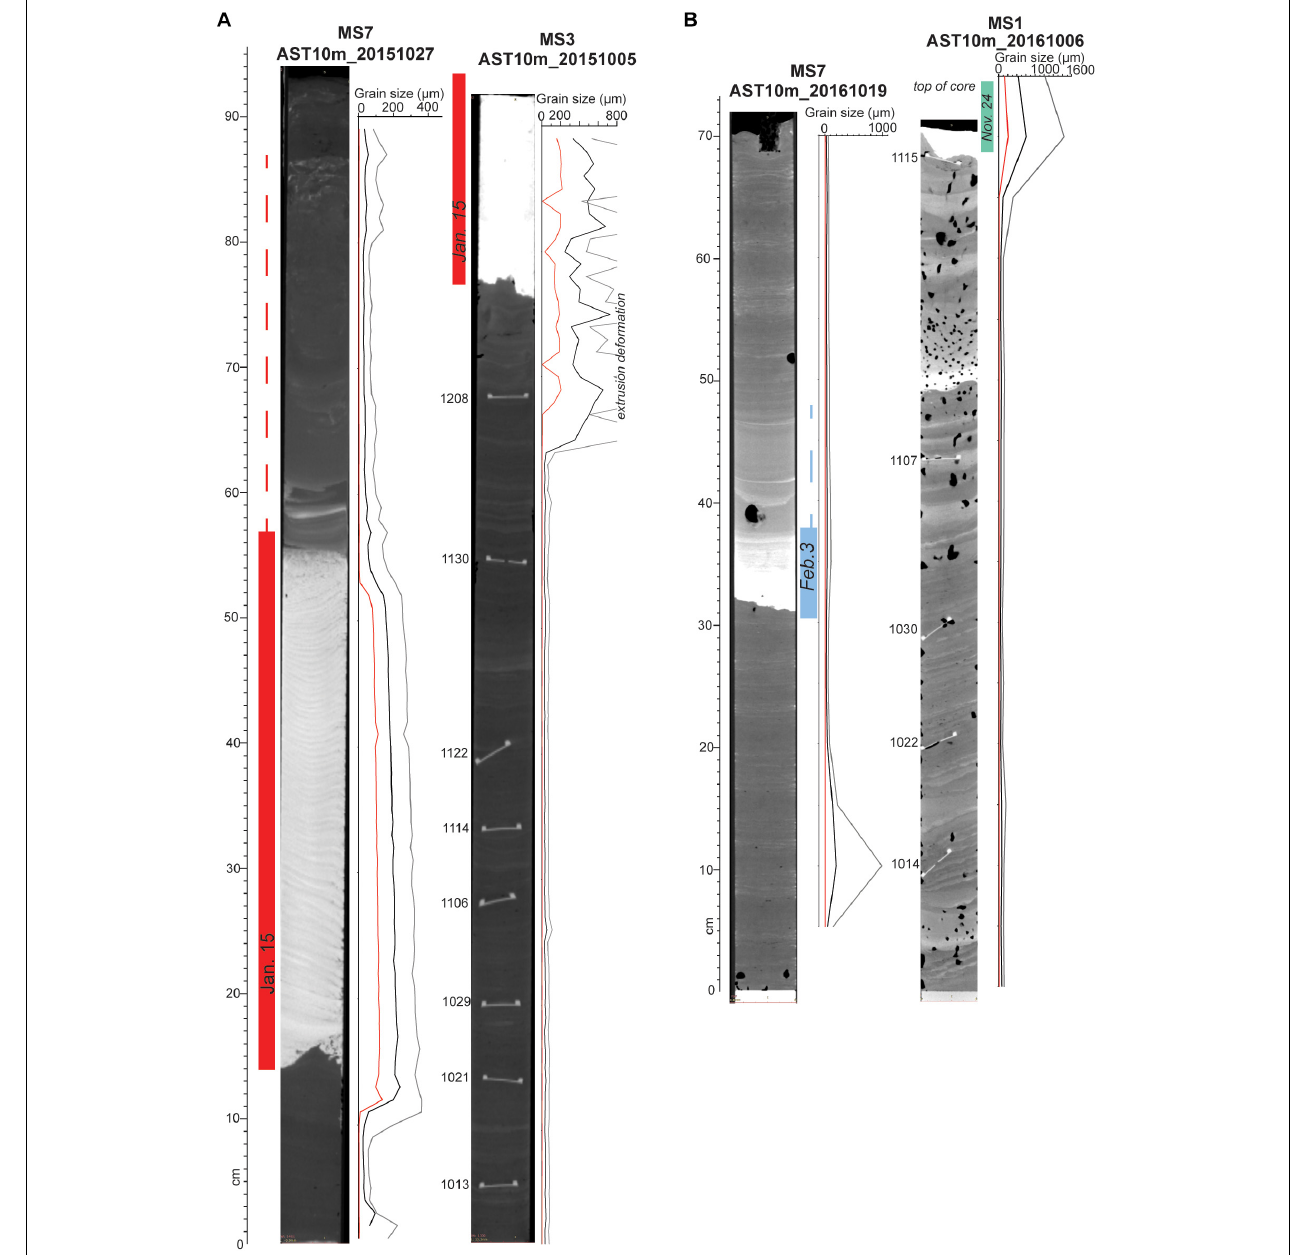
FIGURE 3 | Sediment trap sample examples. Data is shown as computed tomography (CT) images (left; shading adjusted independently for each image) and grain size [right; d0.1 (10 th percentile; red), d[4,3] (volume weighted mean; black), and d0.9 (90 th percentile; gray)]. Intervalometers in the trap funnels deployed disks into the trap tubes at preset intervals during deployment; these disks are seen in cross-section in the CT images and labeled with dates as numeric month and day (e.g., 1122 is November 22). Sediment density flow event units contain coarser sediment (sand) and a lighter shade in CT than fine-grained inter-event units. (A) Deployment I. Sediment units from the January 15, 2016 event are highlighted in red. (B) Deployment III. Sediment units from the February 3, 2017 and November 24, 2016 events are highlighted in blue and green,